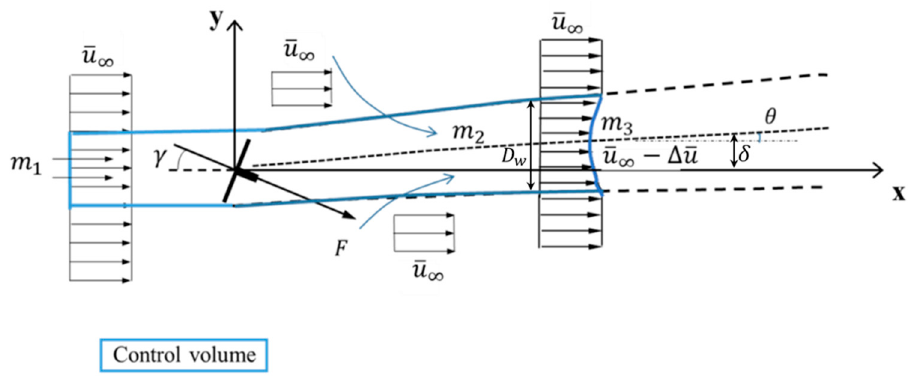
Figure 8. Schematic of the mass and momentum conservation-based model for the wake of a yawed wind turbine. Blue solid lines indicate the control volume.